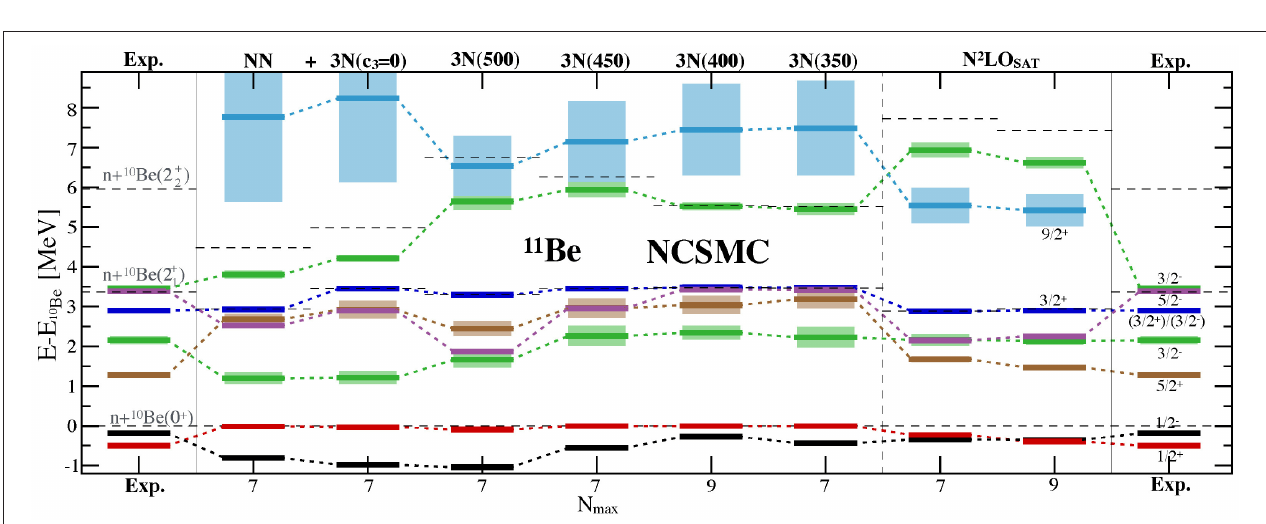
FIGURE 8 | NCSMC spectrum of 11 Be with respect to the n + 10 Be threshold. Dashed black lines indicate the energies of the 10 Be states. Light boxes indicate resonance widths. See reference [ 223] for details. Figure reprinted with permission from the American Physical